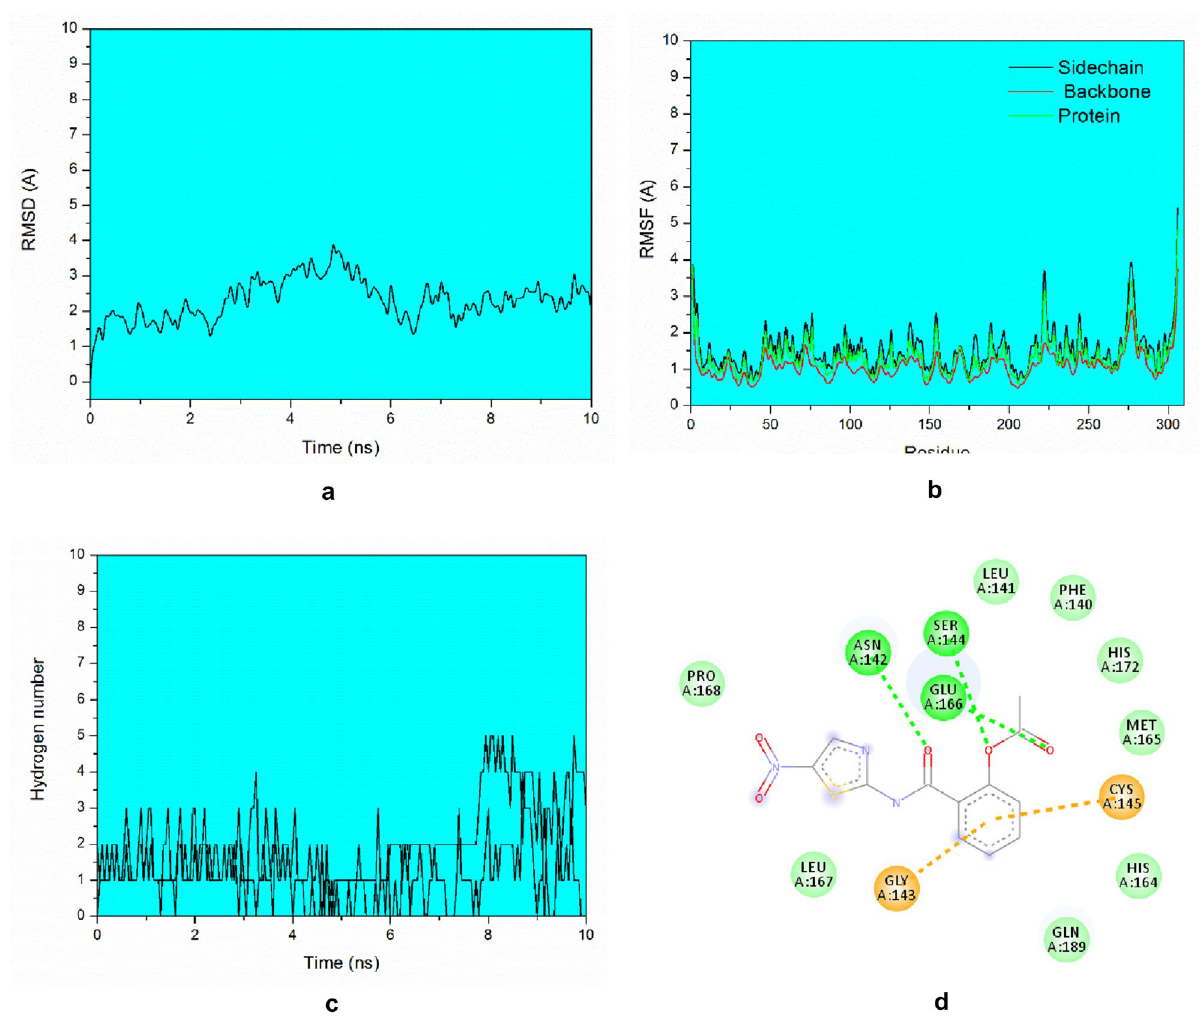
Figure 5. ( a ) 3 RMSD values of Nitazoxanide in the viral M pro site monitored along 10 ns production phase in MD simulations. ( b ) RMSF values of Nitazoxanide. In the viral M pro site obtained by average residual fluctuations over 10 ns MD simulation, analysis performed for the backbone, Protein and Sidechain. ( c ) Number of hydrogen bonds made by Nitazonamide at the Mpro site during molecular dynamics simulation. ( d ) Intermolecular interactions of the fragments of Nitazoxanide in the M pro binding site. Green = hydrogen bond, Orange = hydrophobic